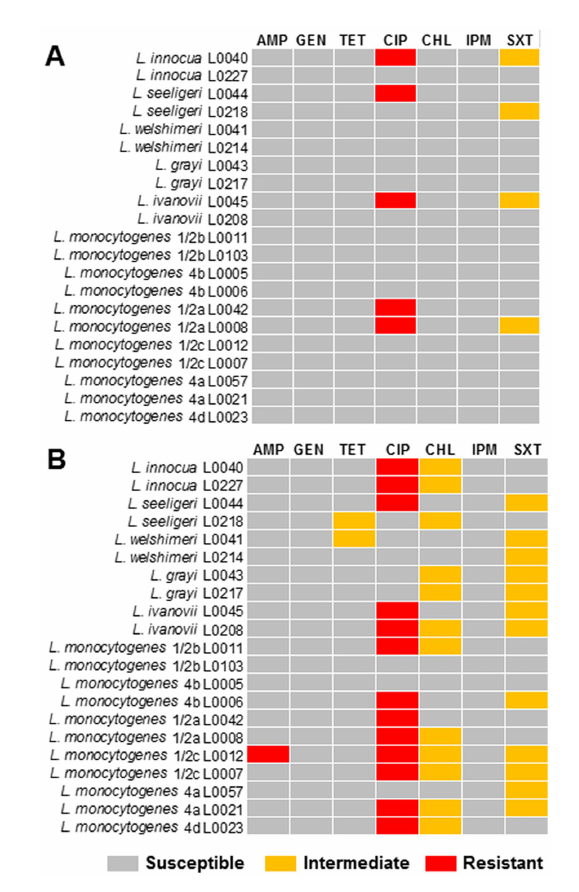
FIGURE 2 Antimicrobial susceptibility testing under the aerobic and anaerobic conditions. AMP: ampicillin, GEN: gentamicin, TET: tetracycline, CIP: ciprofloxacin, CHL: chloramphenicol, IPM: imipenem, SXT: trimethoprim-sulfamethoxazole. (A) The isolates were resistant (red), intermediate resistant (orange) or susceptible (gray) to the tested antibiotics under aerobic conditions. (B) The isolates were resistant (red), intermediate resistant (orange), or susceptible (grey) to the tested antibiotics under anaerobic conditions.